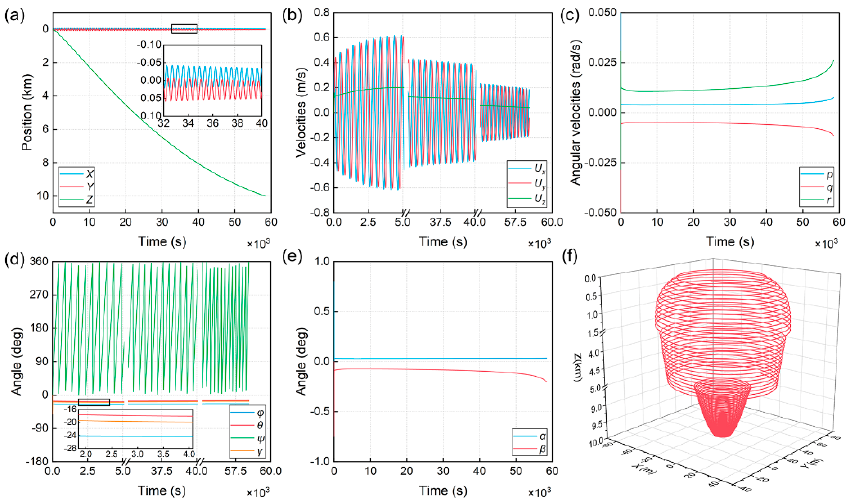
Figure 11. Spiral motion simulation in LR mode: ( a ) Position; ( b ) Velocities; ( c ) Angular velocities; ( d ) Euler angles and gliding angles; ( e ) Attack angle and side slip angle; ( f ) 3D trajectory.